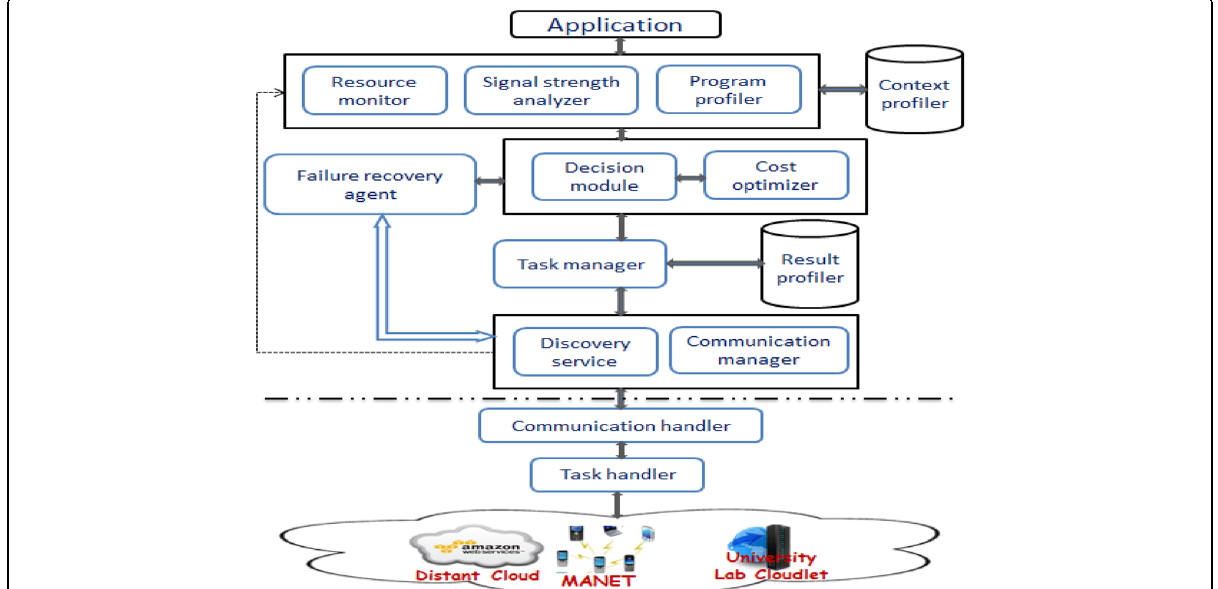
Fig. 3 Architecture components. The proposed framework components presents at application layer groups for mobile device and of cloud resources. The mobile device components are; resource monitor, signal strength analyzer (SSA), decision module, task manager, communication manager, and failure recovery agent. Whereas, the cloud resource components group mainly includes the distant cloud, collaborative-cloud, task handler, and communication